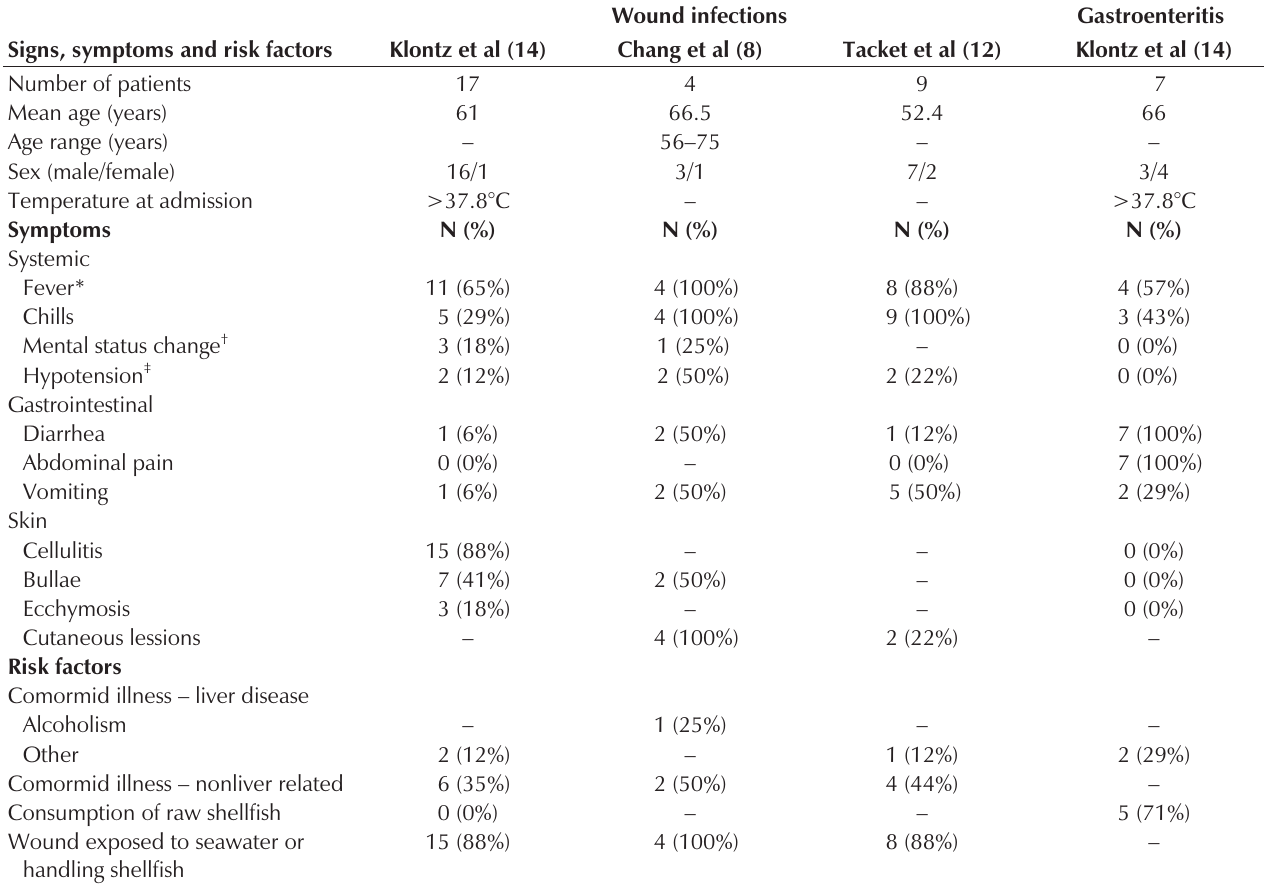
Summary of the signs, symptoms and risk factors associated with Vibrio vulnificus wound infections and gastroenteritis Wound infections Gastroenteritis Signs, symptoms and risk factors Klontz et al (14)